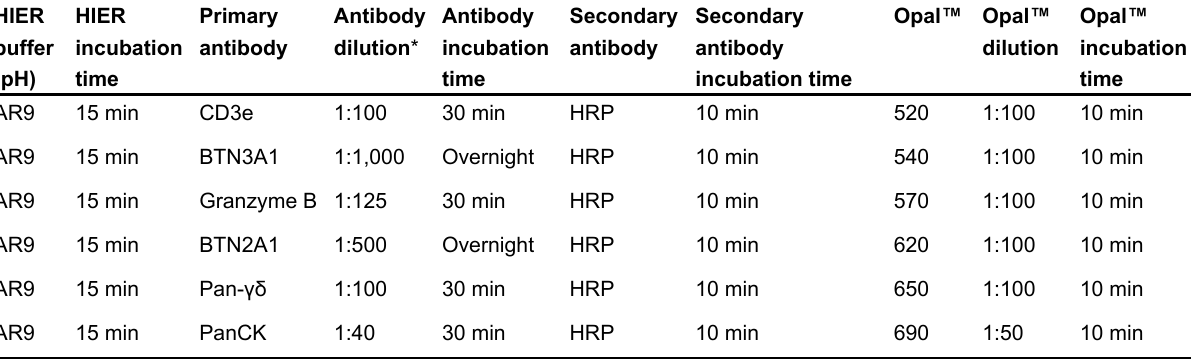
TCR, granzyme B, BTN2A1, BTN3A1, PanCK, and DAPI, while panel 2 is indicated for use in